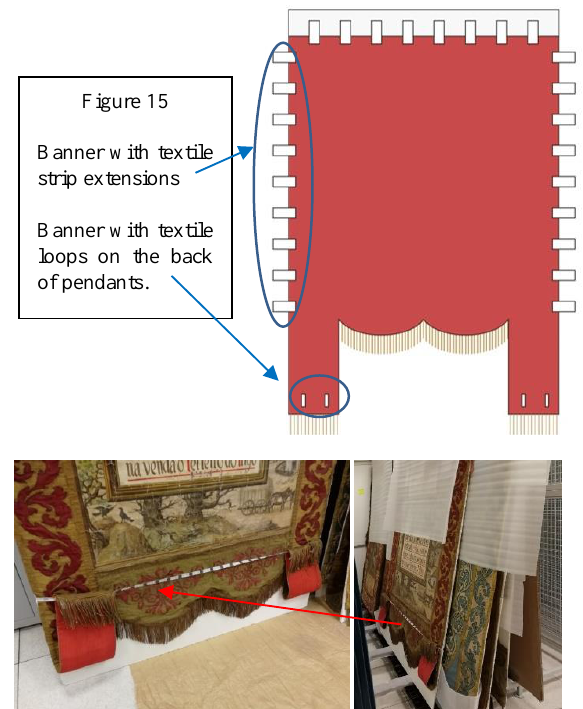
Figure 16 – The designed solution to suspend the pendants too long for the height of the grids and to fix them with textile ribbons.